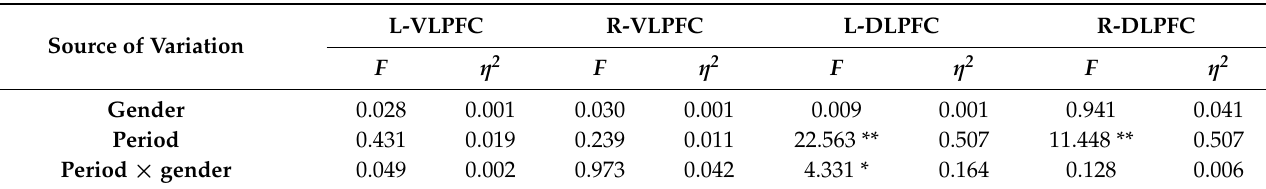
Table 5. The fNIRS data variance (ANOVA) analysis of the effect of orienteering exercises on the spatial memory ability of college students of different genders.